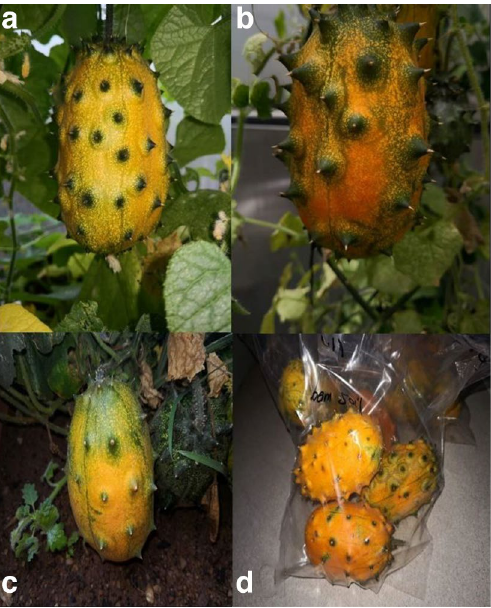
Figure 1. African horned cucumber fruit; ( a ) means fruit grown under (no water stress treatment); ( b ) means fruit grown under (moderate water stress treatment); ( c ) means fruit grown under (severe water stress treatment) and ( d ) means fully ripe fruits harvested for primary metabolites